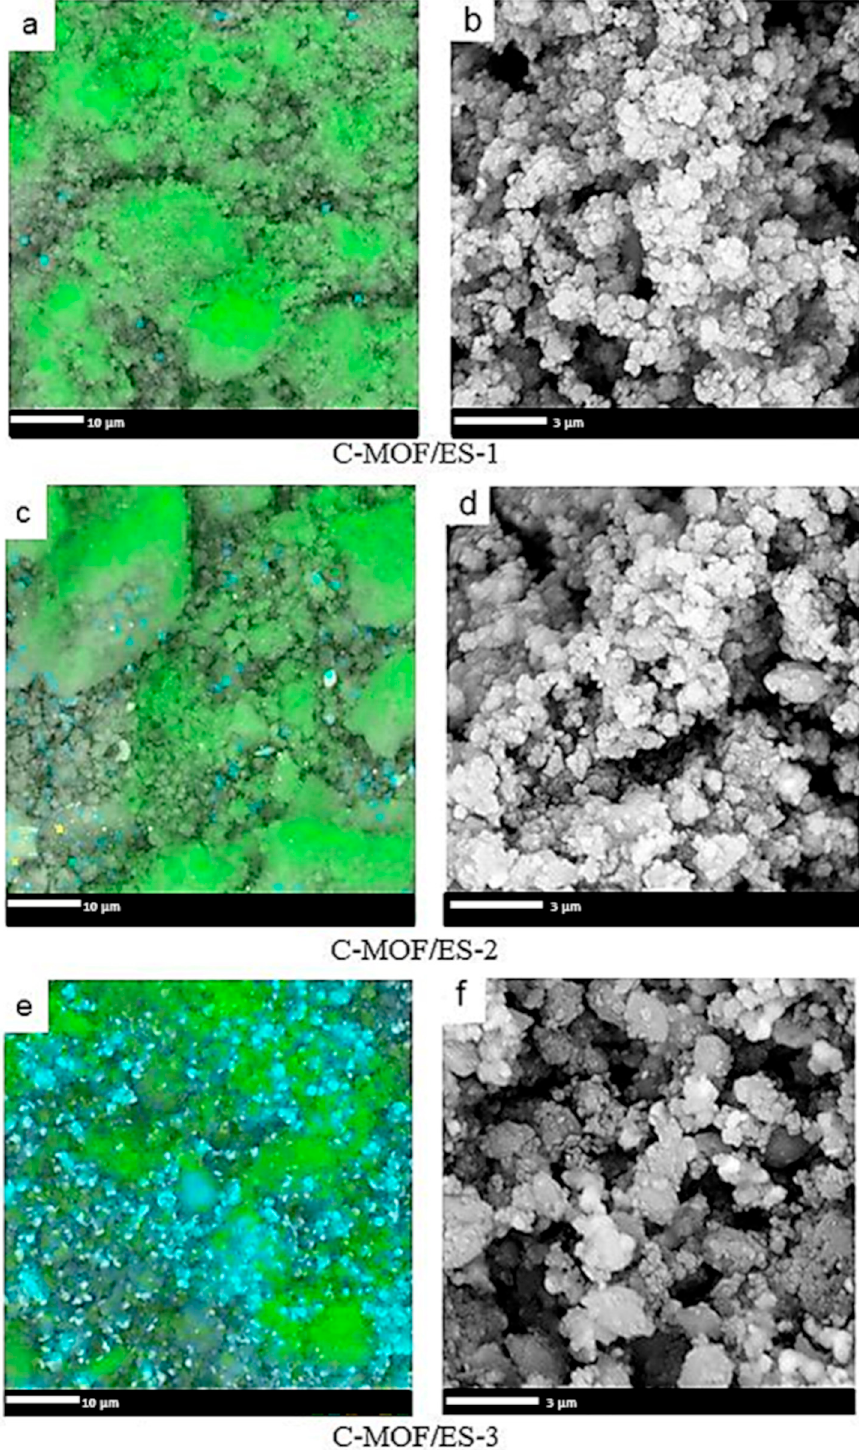
Figure 2. EDX elemental maps ( a , c , e ) and SEM images ( b , d , f ) of C-(MOF-5/PANI) samples of the C-MOF/ES series: ( a , b ) C-MOF/ES-1, ( c , d ) C-MOF/ES-2, and ( e , f ) C-MOF/ES-3. The scale bar on EDX and SEM images is 10 μ m and 3 μ m, respectively. The most abundant elements in EDX maps, C and Zn, are marked with green and turquoise, respectively.